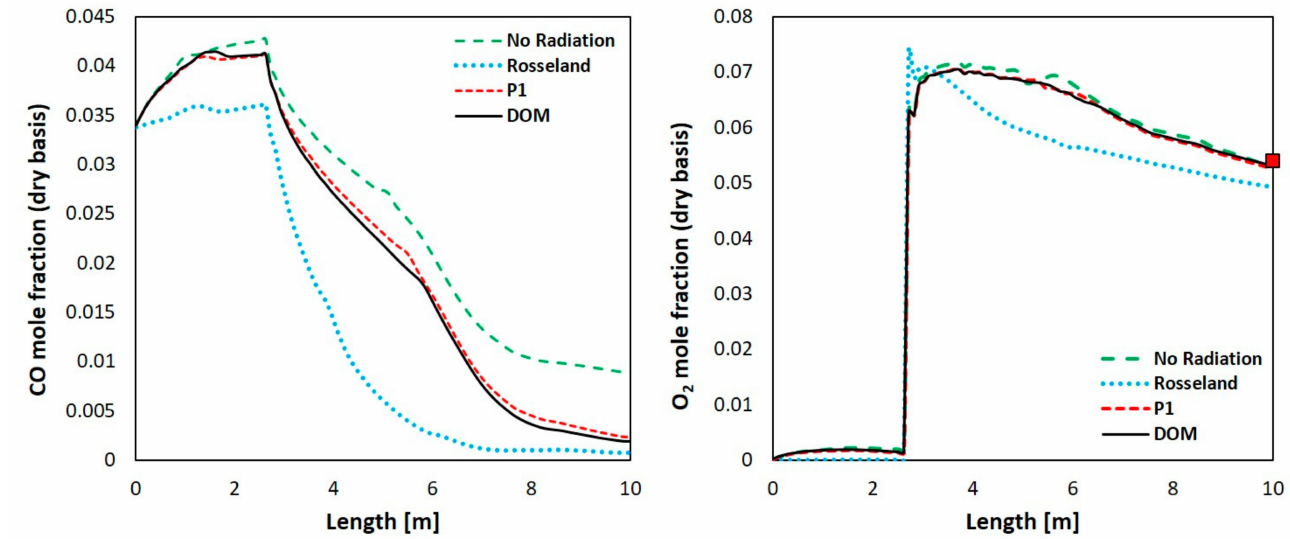
Figure 18. Predicted average cross-sectional CO and O 2 composition profile along the reflux chamber.